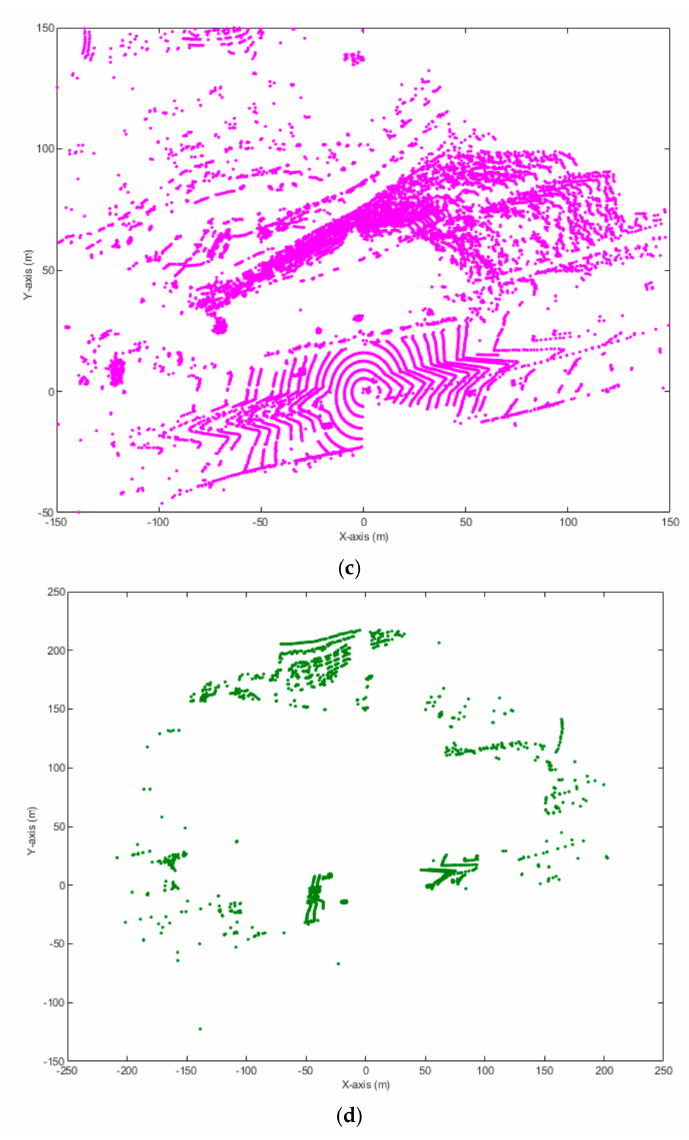
Figure 2. Performance of 3D density statistic filtering (3D-DSF) under windy and non-windy weather: ( a ) No wind before applying 3D-DSF, ( b ) No wind after applying 3D-DSF, ( c ) Strong wind before applying 3D-DSF, ( d ) Strong wind after applying